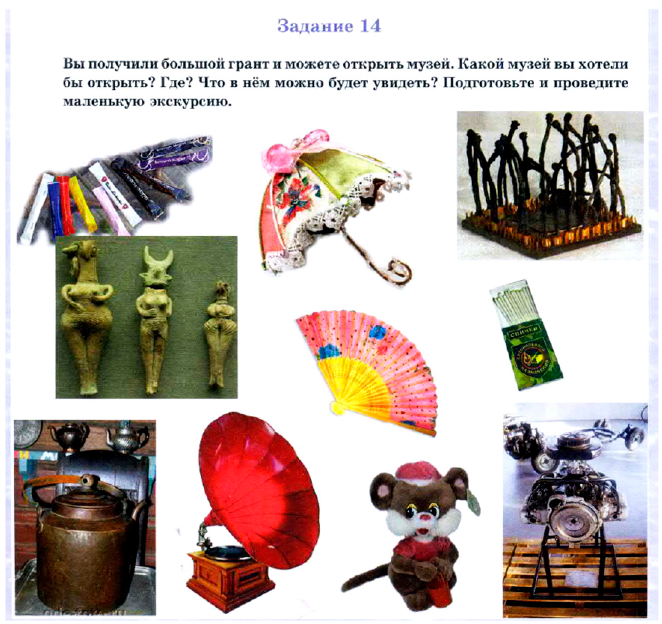
Figure 9. Example 1 of a task in Poyekhali .